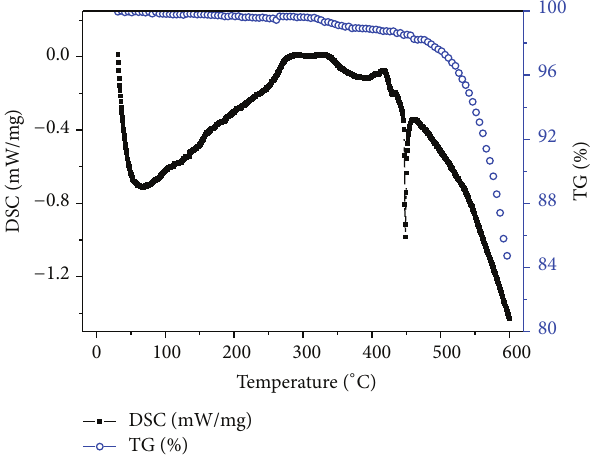
Figure 2: TG and DSC analysis of the as-deposited films.